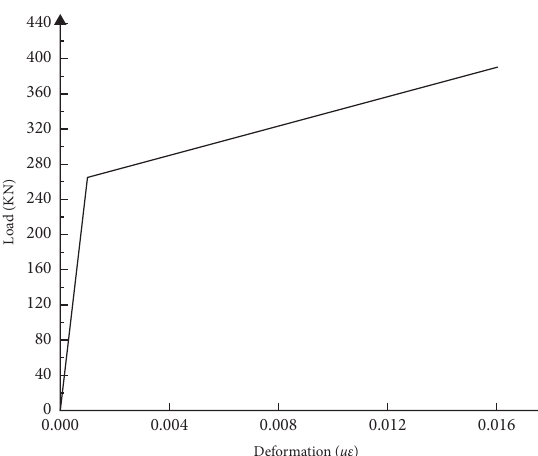
Figure 6: Double line diagram of